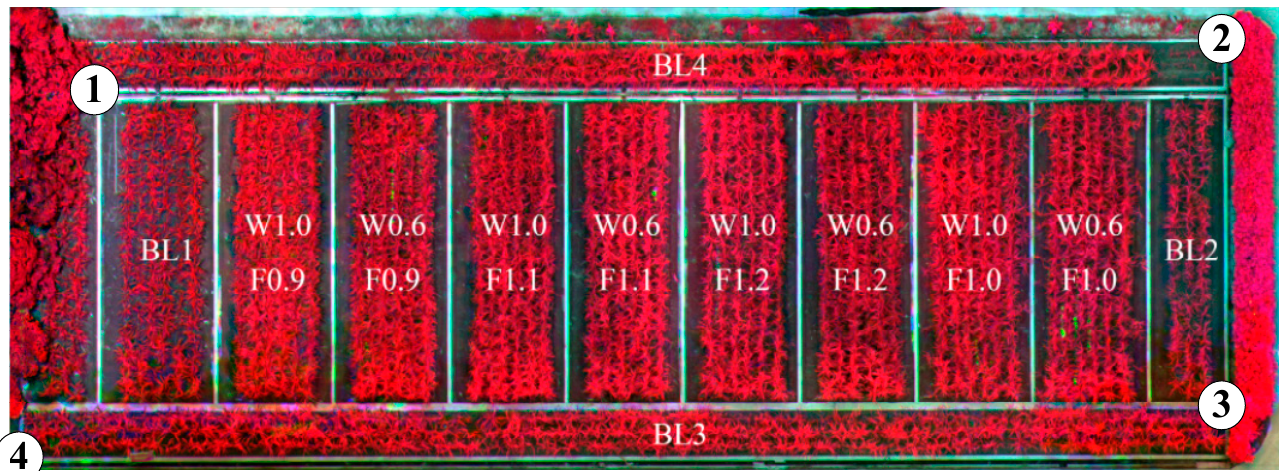
Figure 4. The false-color (NIR, R, and G) mosaic image of the sugarcane experimental field. The white-circled numbers represent the four ground control points.